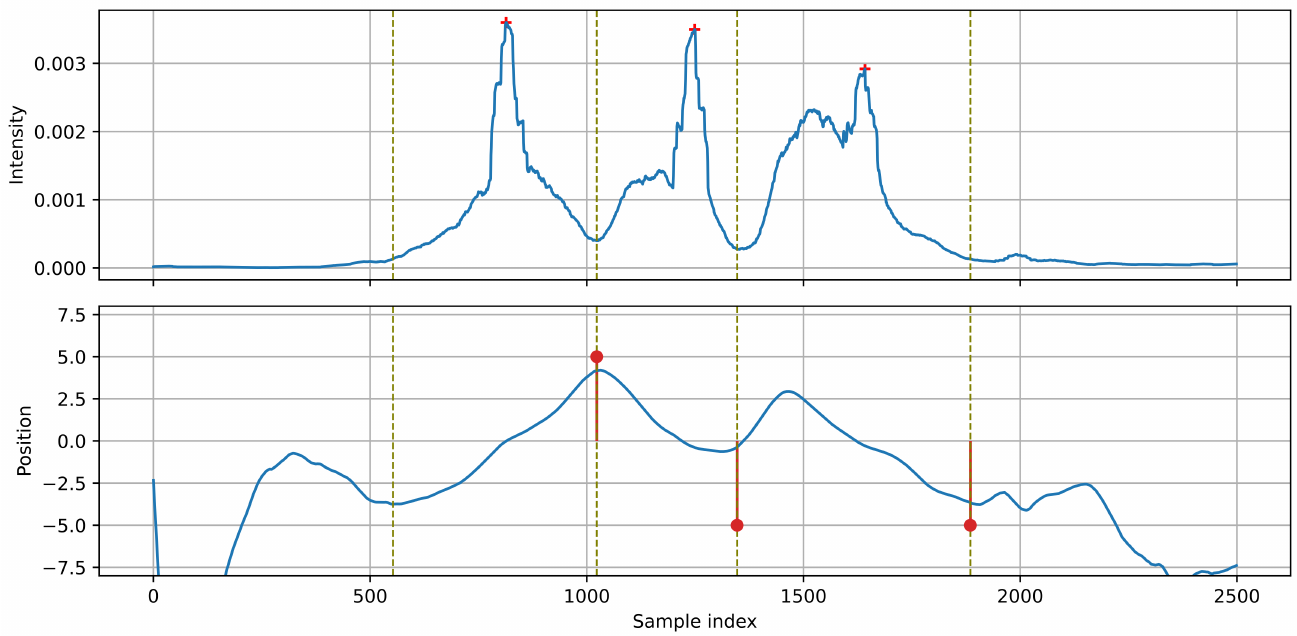
Figure 9. Example of detection: vehicles passing each other, moving in the opposite